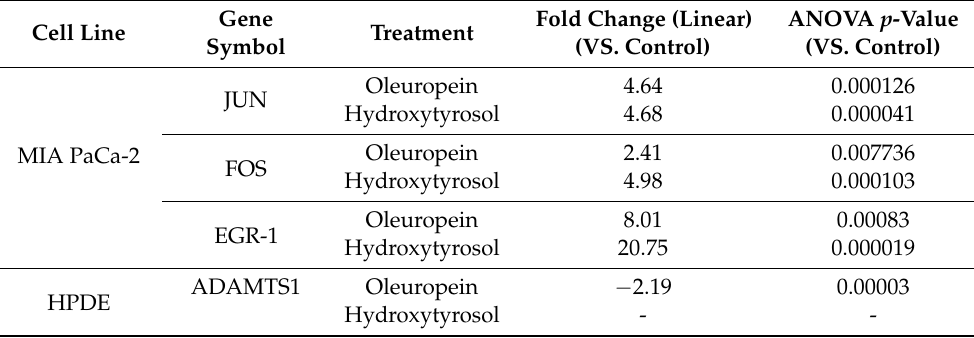
Table 2. Fold change in the gene expression of JUN , FOS and EGR-1 in pancreatic cancer cells (MIA PaCa-2) and ADAMTS1 in non-tumorigenic cells (HPDE) when treated with oleuropein or hydroxytyrosol. Fold Change (Linear) Gene Treatment Cell Line (VS. Control) (VS. Symbol